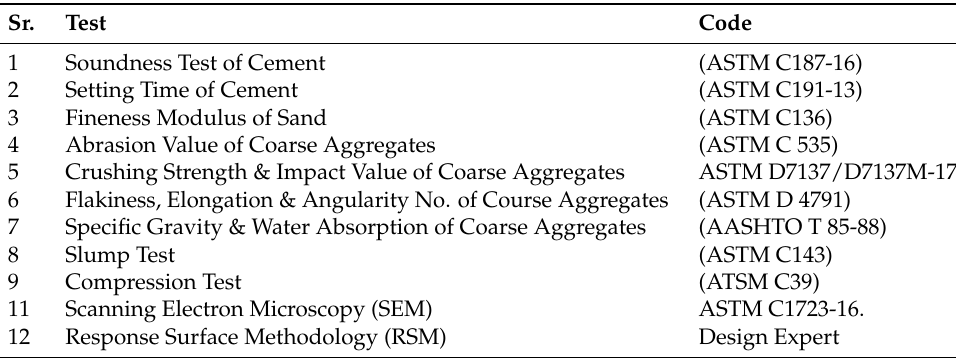
Table 4. Tests for measuring standards of the